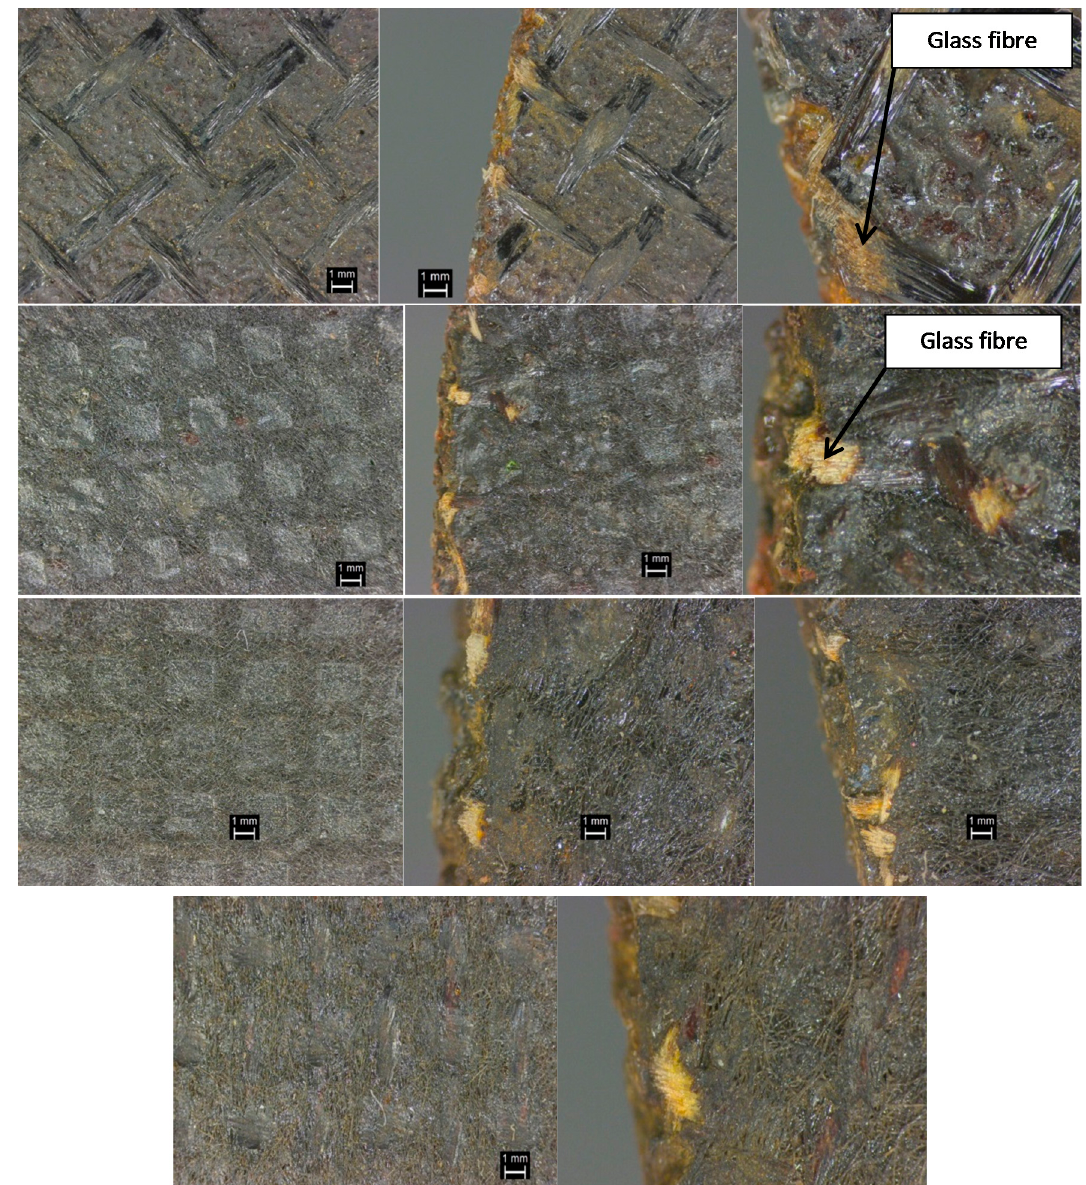
Figure 7. From top to bottom: (1st row) XR picture of the structure of DE disc, (2nd row) XR picture of